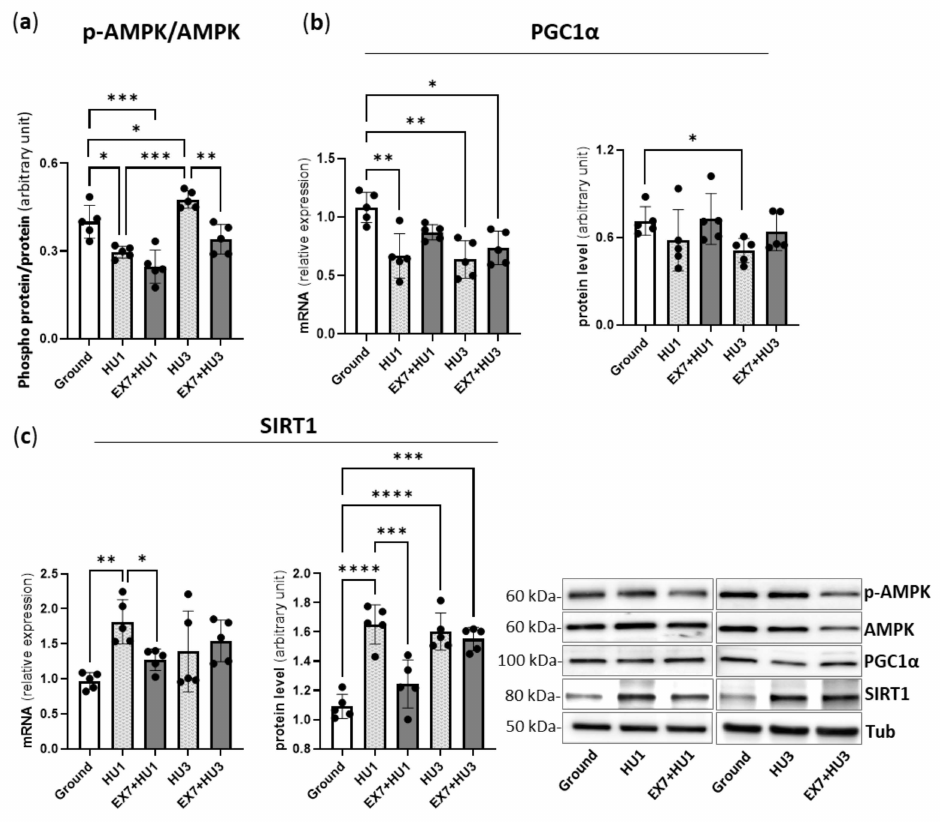
Figure 6. Effects of hindlimb unloading and exercise preconditioning on FoxO regulators. Activation level of AMP-kinase ( a ), Gene expression and protein content analysis of PGC1 α ( b ), gene expression and protein content analysis of SIRT1 ( c ), and relative representative Western blot. Ground: Control mice ; HU1: Mice subjected to 1 day of hindlimb unloading; EX7 + HU1: Mice subjected to 7 days of physical preconditioning followed by 1 day of hindlimb unloading; HU3: Mice subjected to 3 days of hindlimb unloading; EX7 + HU3: Mice subjected to 7 days of physical preconditioning followed by 3 days of hindlimb unloading. Data are presented as means ± SD * p < 0.05 ** p < 0.005 *** p < 0.0005 **** p < 0.0001. Gene expression levels were determined by RT-PCR analysis and normalized on GAPDH . Protein content levels were determined by Western blot analysis and normalized for